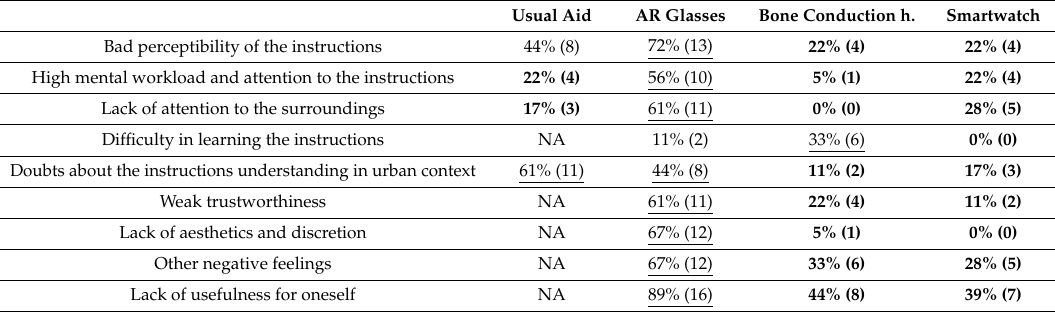
Table 2. Number and percentage of participants facing difficulties while navigating the city with the four aids. The percentages in bold font are significantly lower than the ones that are underlined on the same row. NA means the related dimension was absent in the